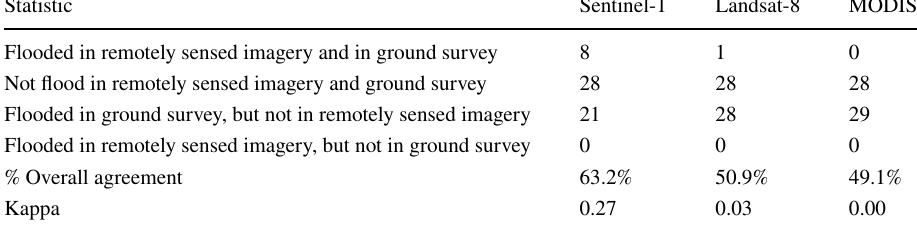
Table 3 Number of water points classified as flooded through ground survey, compared to their classification via three different remotely sensed flood products (derived from Landsat 8, Sentinel-1, and MODIS), with related accuracy assessment